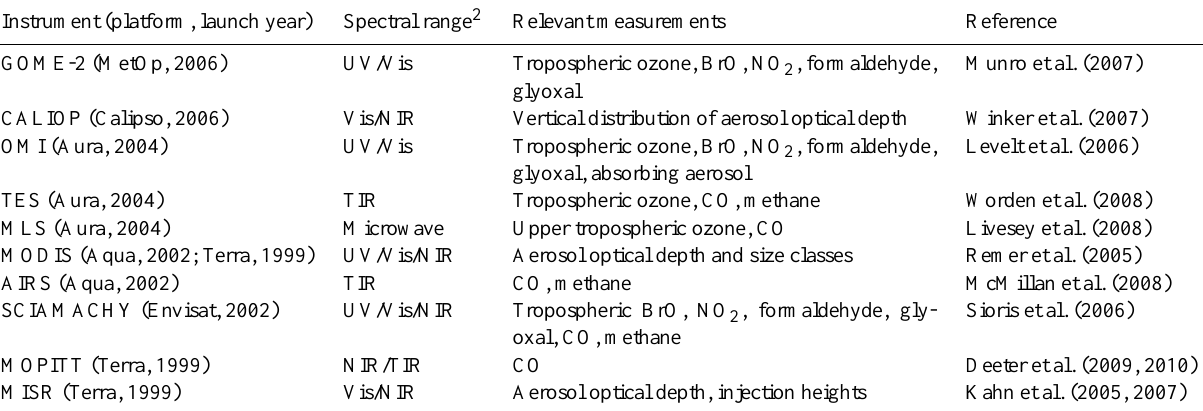
Table 1. Satellite measurements of atmospheric composition during ARCTAS 1